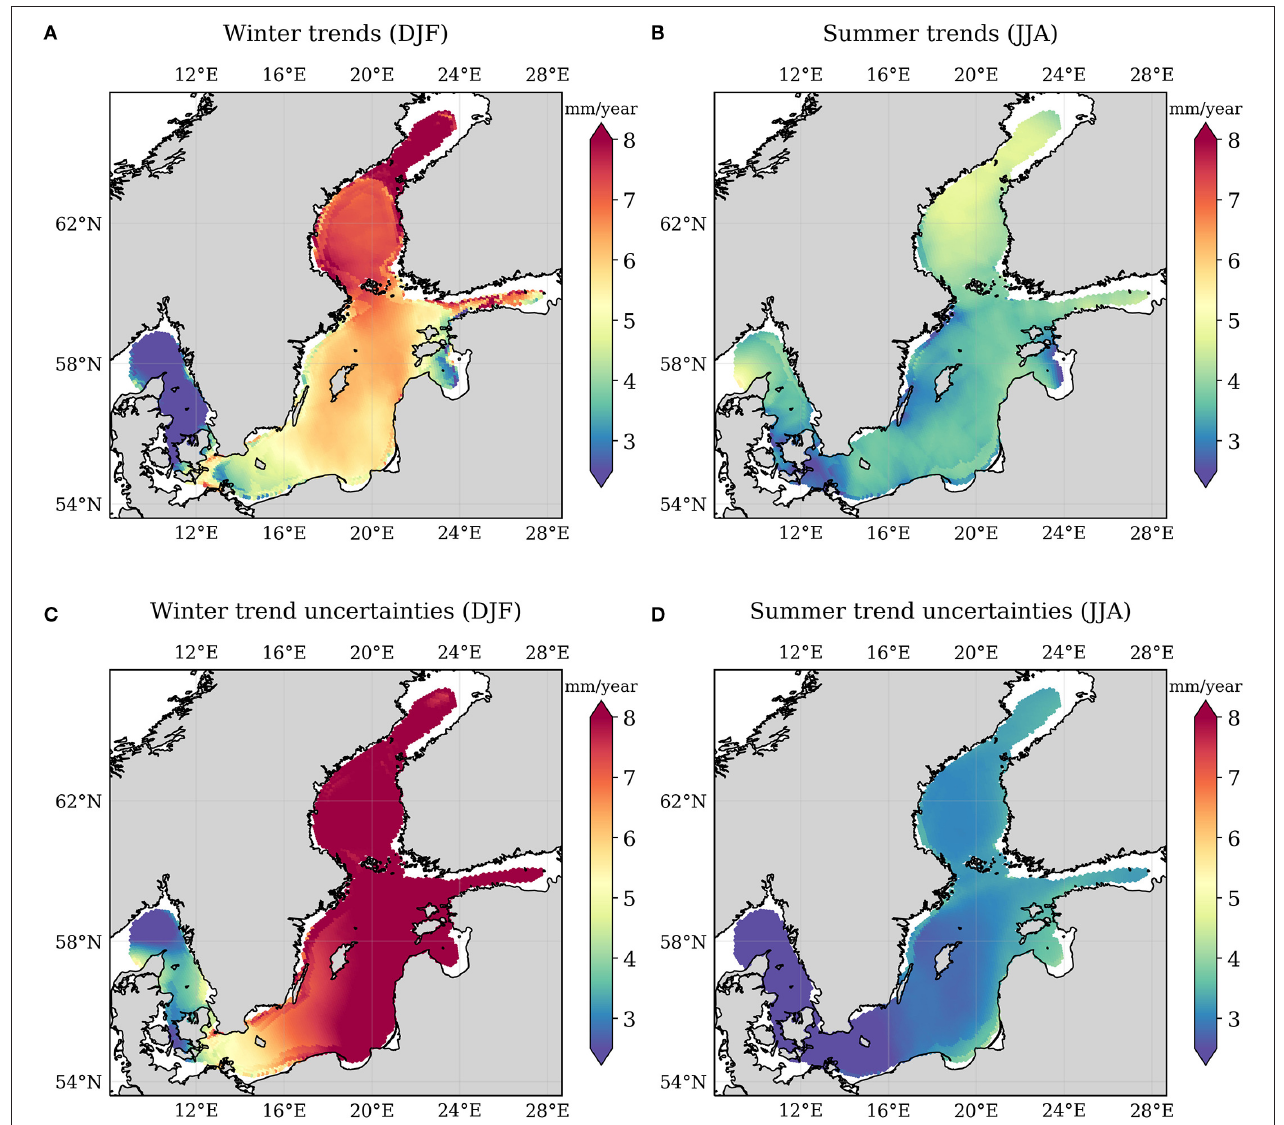
FIGURE 7 | SL trends with uncertainties from gridded altimetry computed using only the winter months (December, January, and February, A,C ) and the summer months (June, July, and August, B,D